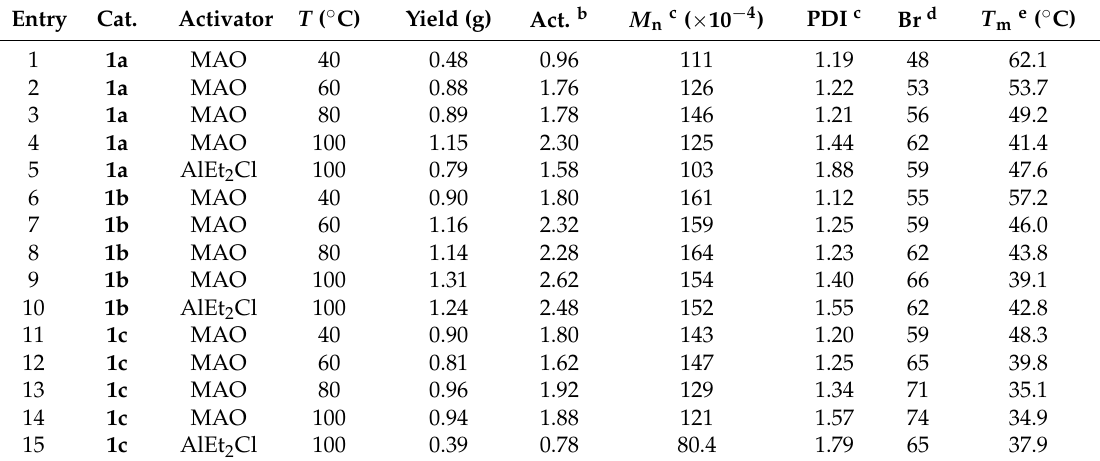
Table 1. Ethylene polymerization results with complexes 1a – 1c .